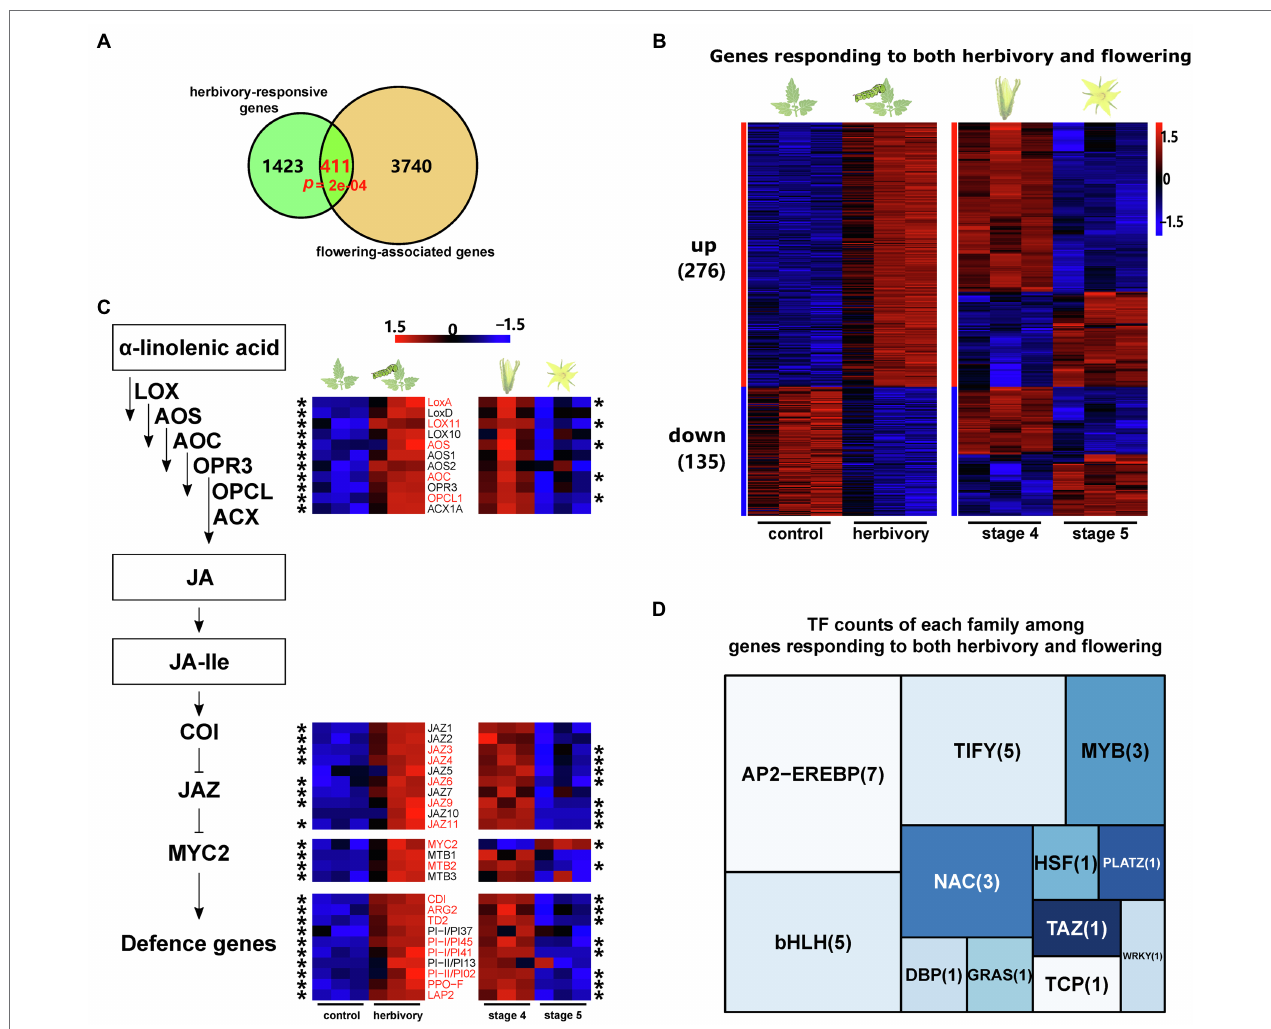
FIGURE 3 | Shared transcriptomic responses during flower development and leaf herbivory. (A) Venn diagram showing the overlap between the flowering- associated genes (orange circle) and herbivory-responsive genes (green circle) in domesticated tomato. p denotes the probability to obtain the observed overlap by chance and was analysed by permutation test, n = 10,000. (B) Heat maps showing the expression patterns of all shared DEGs in control and herbivore-infested leaves (left) and in flowers of stages 4 and 5 (right). ‘up’ means genes upregulated by herbivory, and ‘down’ means genes downregulated by herbivory. The numbers in brackets are the corresponding gene numbers. Gene expression levels were log 10 -transformed and z-score normalised. (C) Transcript response of genes related to JA biosynthesis, signalling and inducible plant defence after herbivory and during flower development. The heat maps show the expression patterns in control and herbivore-infested leaves (left), as well as in flowers of stages 4 and 5 (right). Only genes showing significant expression difference during herbivory or flower development are shown in the heat maps. Asterisks indicate that the expression of the respective gene was significantly different during the corresponding process. The genes highlighted in red significantly responded to both processes. Gene expression data were log 10 -transformed and z-score normalised. Each treatment had three replicates. (D) Tree map showing the number of TF genes responding to both herbivory and flower development, sorted by TF